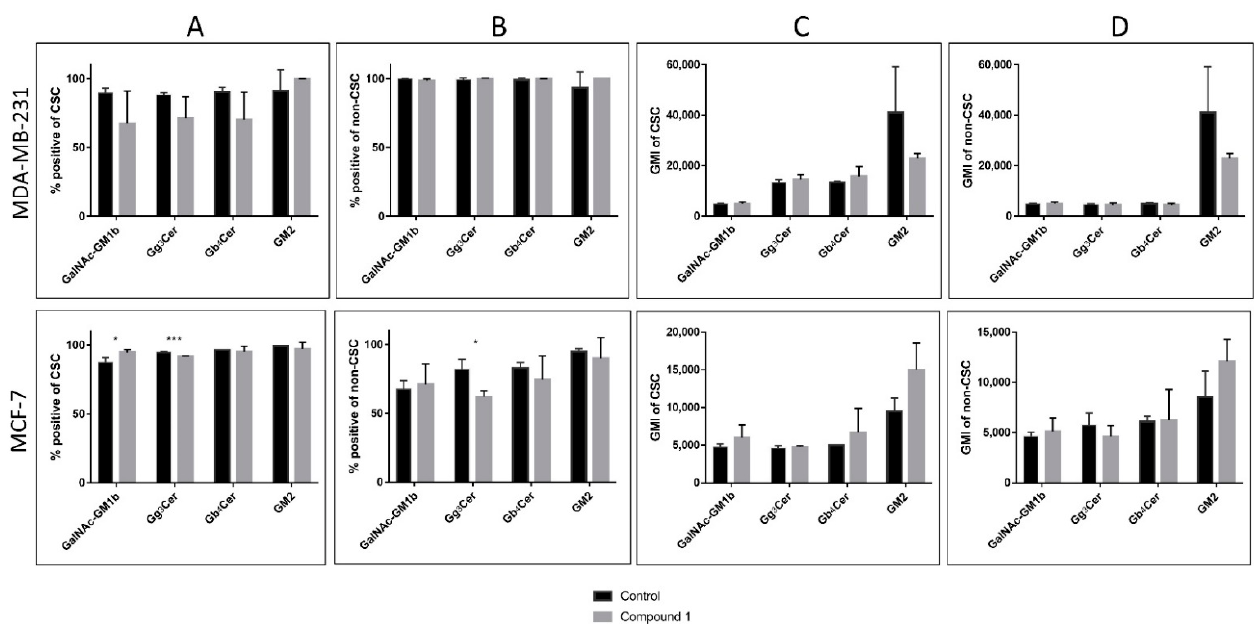
Figure 6. Percentage and geometric mean fluorescence intensity of cell subpopulations positive for ganglioside and neutral GSLs with terminal GalNAc residue. Notes : Percentage of CSCs in the MDA-MB-231 and in the MCF-7 ( A ), and non-CSCs in MDA-MB 231 and in the MCF-7 cell lines ( B ). Geometric mean fluorescence intensity of CSCs in MDA-MB 231 and in the MCF-7 ( C ), and non-CSCs in the MDA-MB-231 and in MCF-7 cell lines ( D ) after treatment with compound 1 in duration of 48 h. Data are expressed as a mean from experiment performed in triplicate ± SD. Columns, mean of viable cells; bars, SD, * p < 0.05, *** p < 0.001. CSC, CD44 + /CD24 − cells; non-CSC, CD44 + /CD24 +